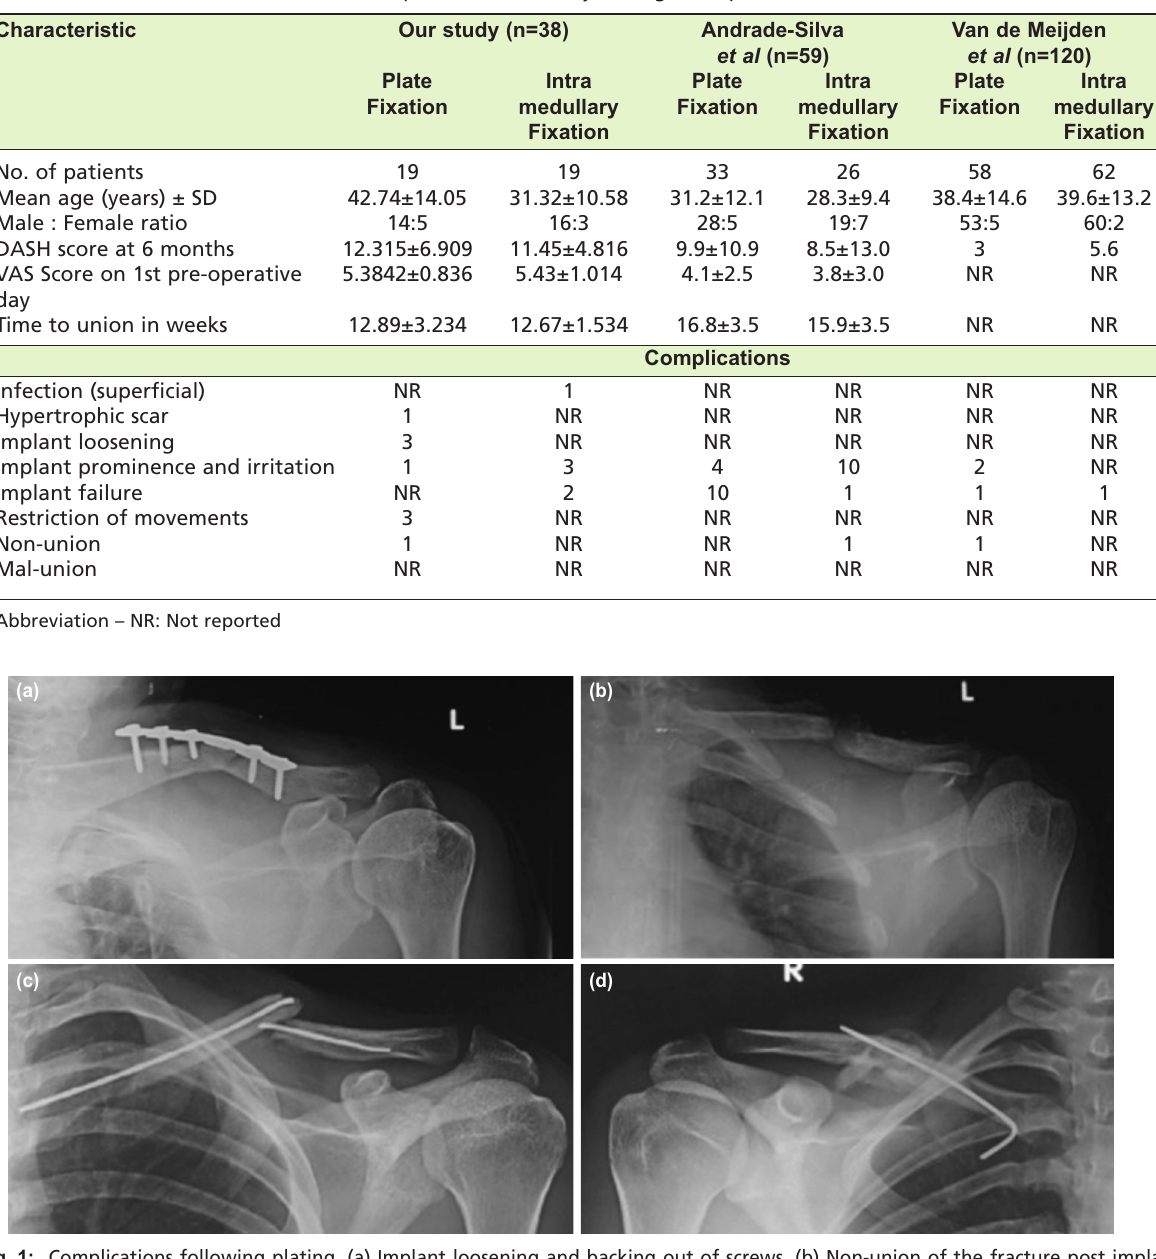
Comparison of our study findings with previous studies Table IV: